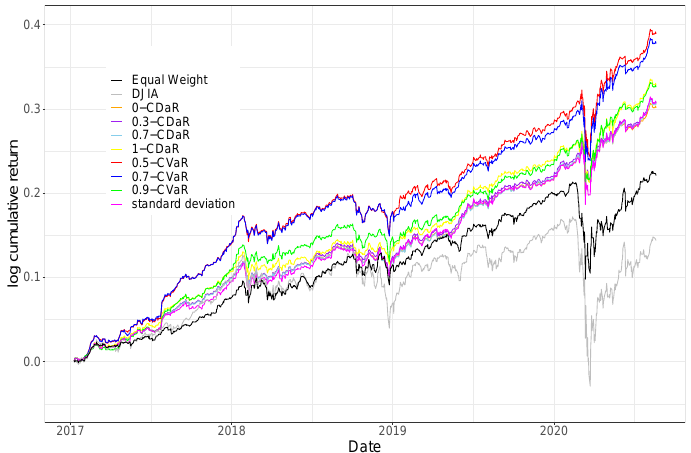
Figure 1. Log cumulative returns: this figure plots the time series of log cumulative return of optimal portfolios with different risk measures, the DJIA index and the equally weighted portfolio. The risk measures used in portfolio optimization are 0-CDaR, 0.3-CDaR, 0.7-CDaR, 1-CDaR, 0.5-CVaR, 0.7-CVaR, 0.9-CVaR and standard deviation.